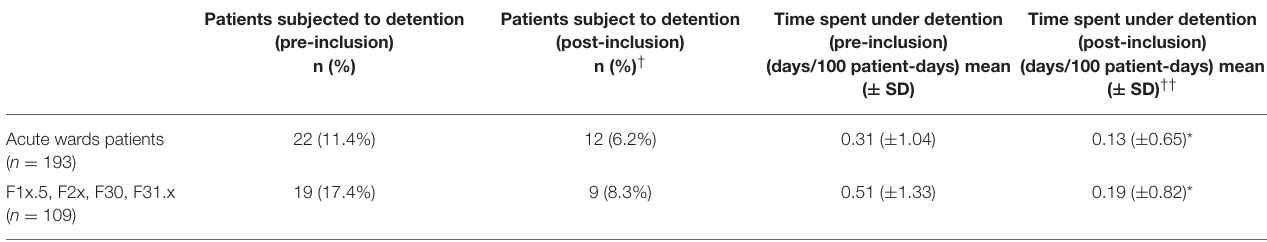
TABLE 4 | Number of patients subject to compulsory detention and average duration of compulsory detention before and after inclusion in the model project. Patients subjected to detention